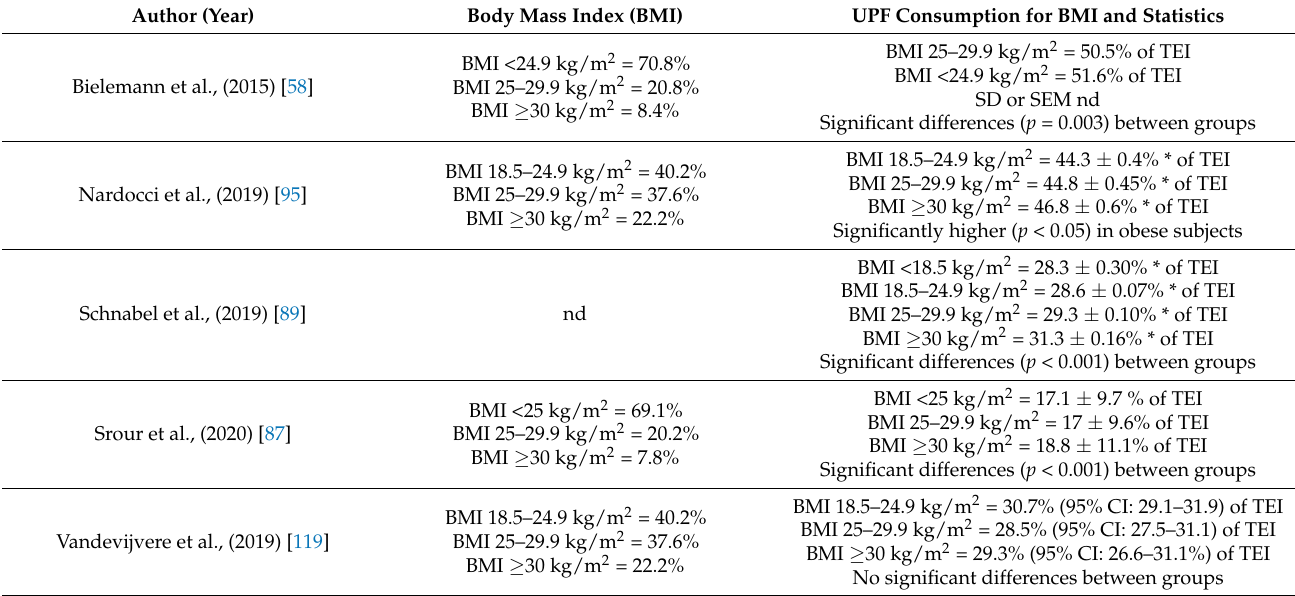
Table 4. Level of consumption of ultra-processed foods (UPF) expressed as % energy provided by UPF intake with respect to total energy intake (TEI) by considering the BMI